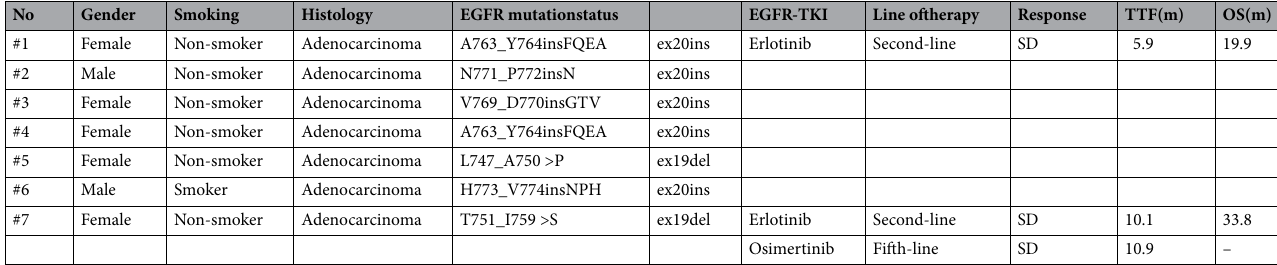
Table 2. Profiles of overlooked EGFR